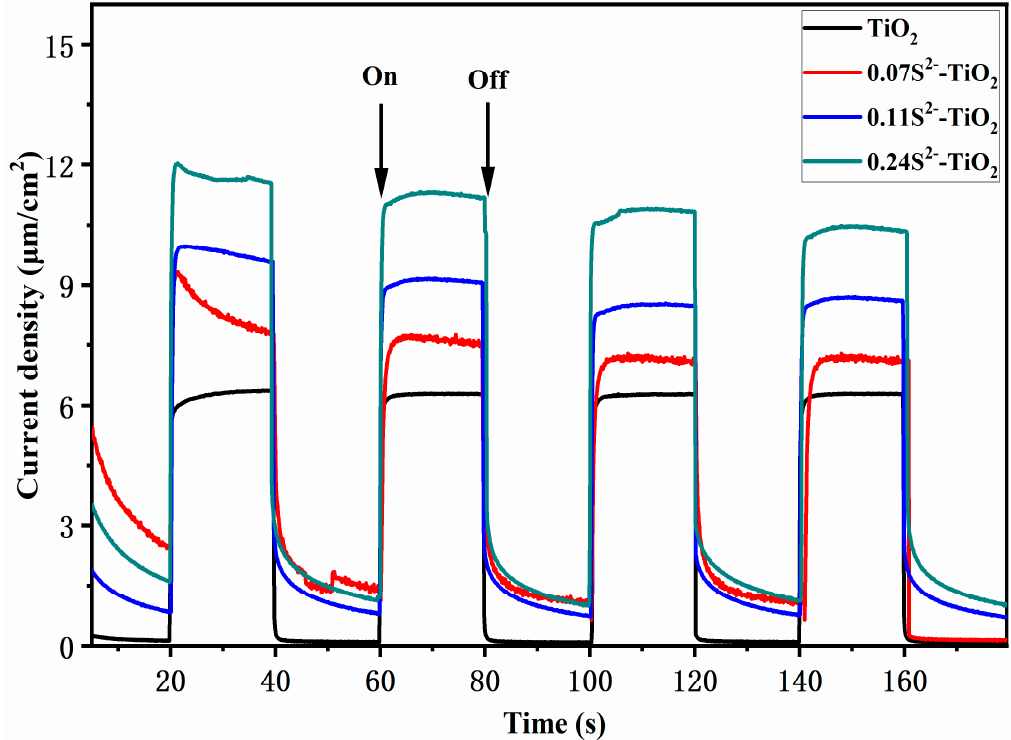
Figure 7. Transient photocurrent responses of different samples.